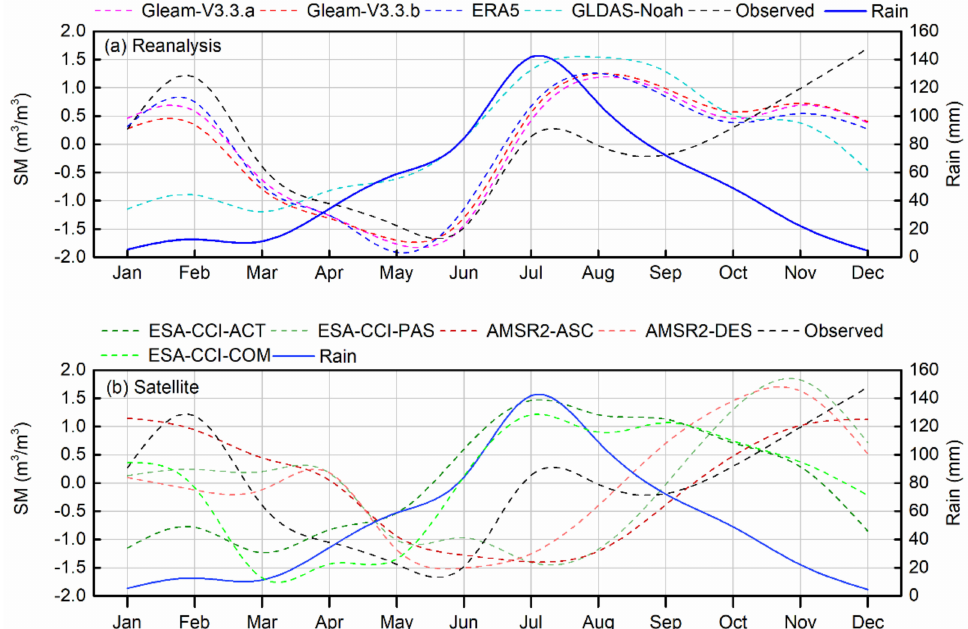
Figure 5. Seasonality of soil moisture distribution among reanalysis ( a ) and satellite SM products ( b ), and precipitation, averaged over the semi-humid areas. (Note that all data series were standardized using the Z-score